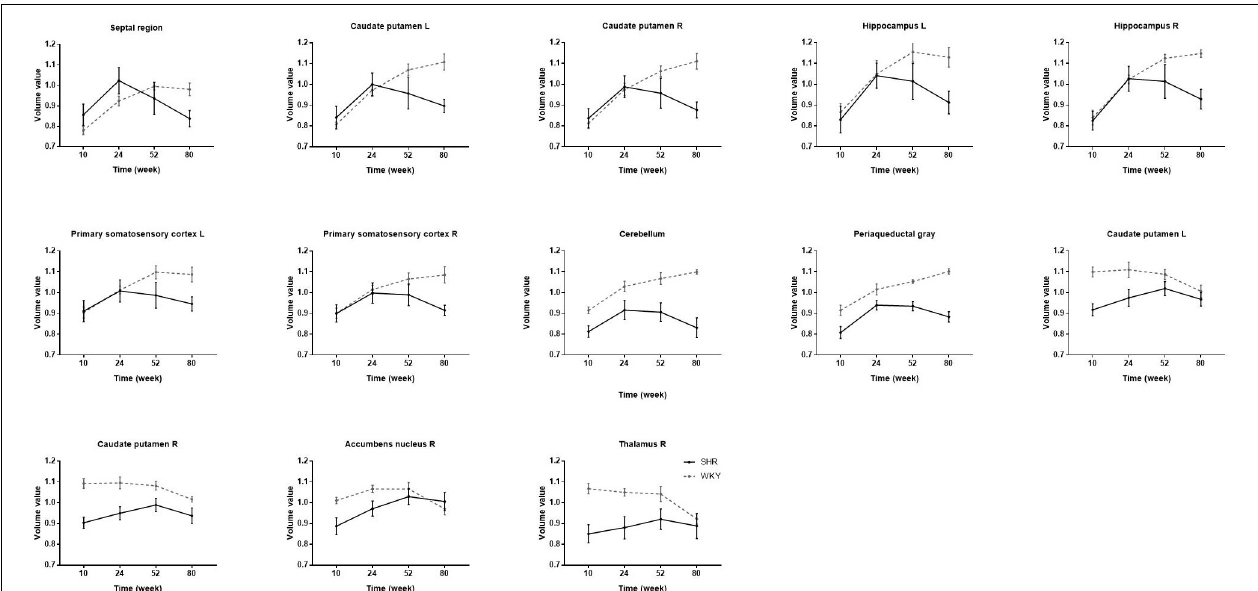
FIGURE 3 | The volume changes in each cluster with interactions of group and age in SHRs and WKY rats aged 10, 24, 52, and 80 weeks. Temporal trajectories of each cluster morphology show obvious heterogeneity, which is different across regions. Compared with WKY rats, elderly SHRs exhibit severe gray matter atrophy. As early as 24 weeks of age, gray matter volume begins to atrophy significantly in the septal region, bilateral caudate putamen, and hippocampus.